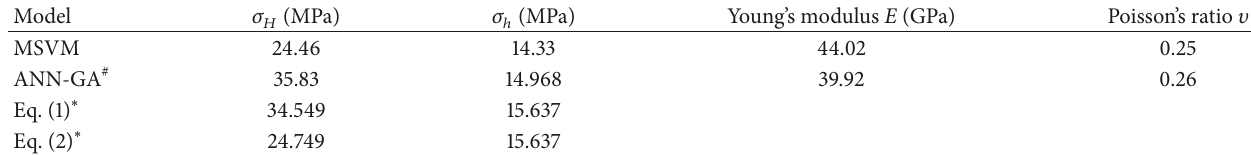
Table 1: Comparison of in situ stresses and mechanical parameters between MSVM model and other preexisted models.